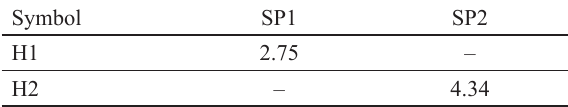
Table 5. The dosage of SP by weight of total binder, %